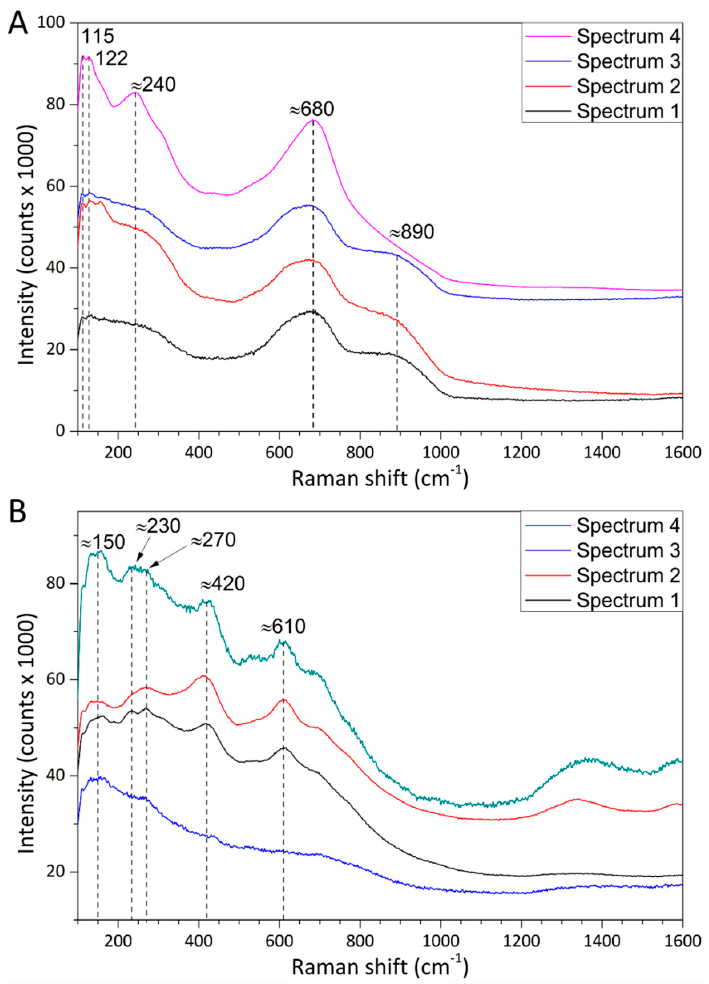
Figure 5. Micro-Raman spectra acquired on the surface of the working parts of the Procodile ( A ) and Reziflow ( B ) files. Spectra 1–4 were acquired at distinct, randomly chosen positions.